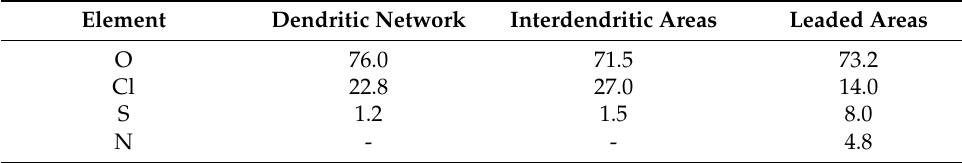
conducted in dendritic, interdendritic areas and Pb islets.